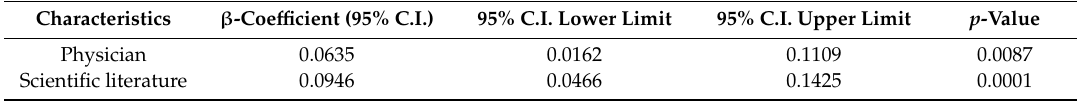
Table 3. Multivariate analysis for predicting attitude